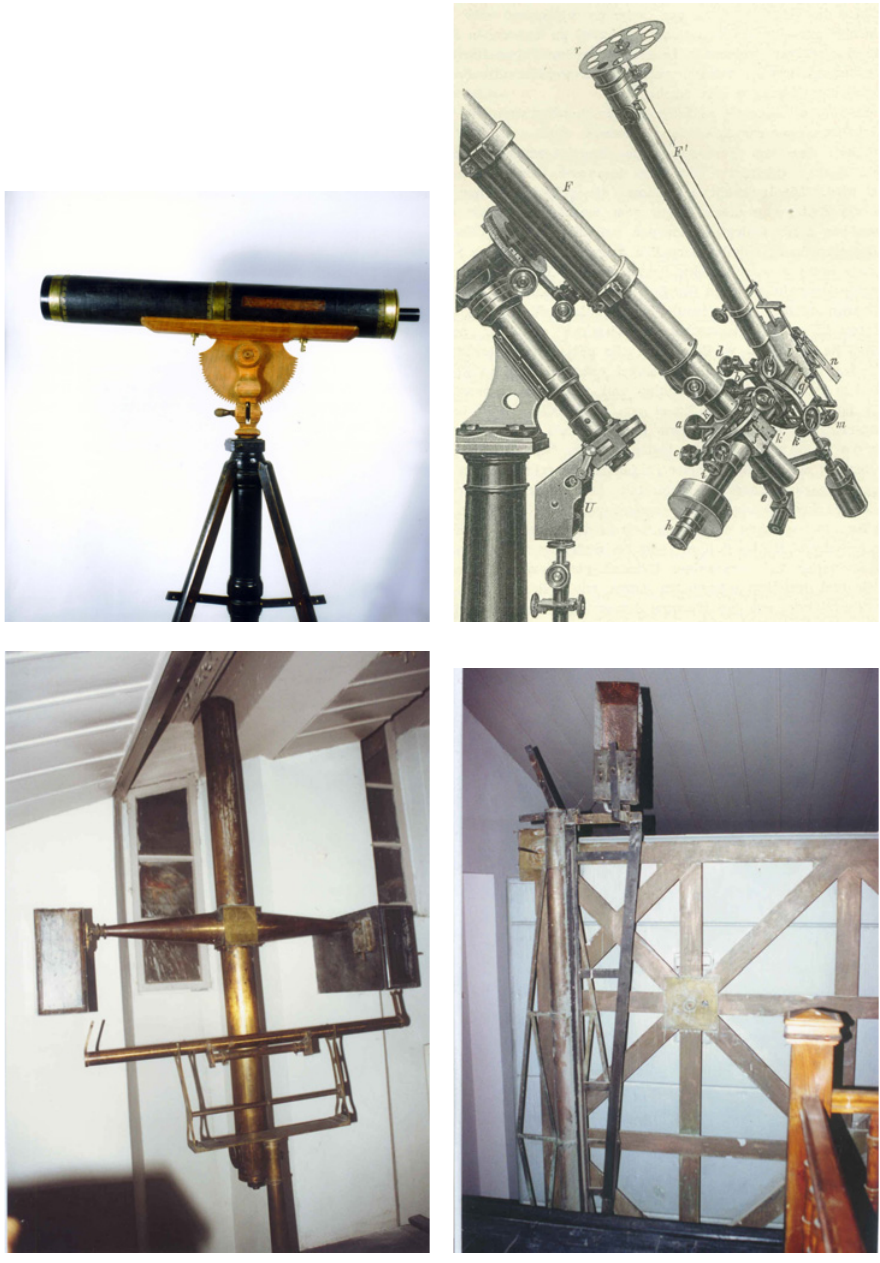
Fig. 1. Top-left: 5-inch reflecting telescope (18th century) – the first telescope of the Observatory; top-right: drawing of Schwerd’s photometer; bottom-left: transit instrument made by J. Ramsden; bottom-right: mural quadrant made by J.